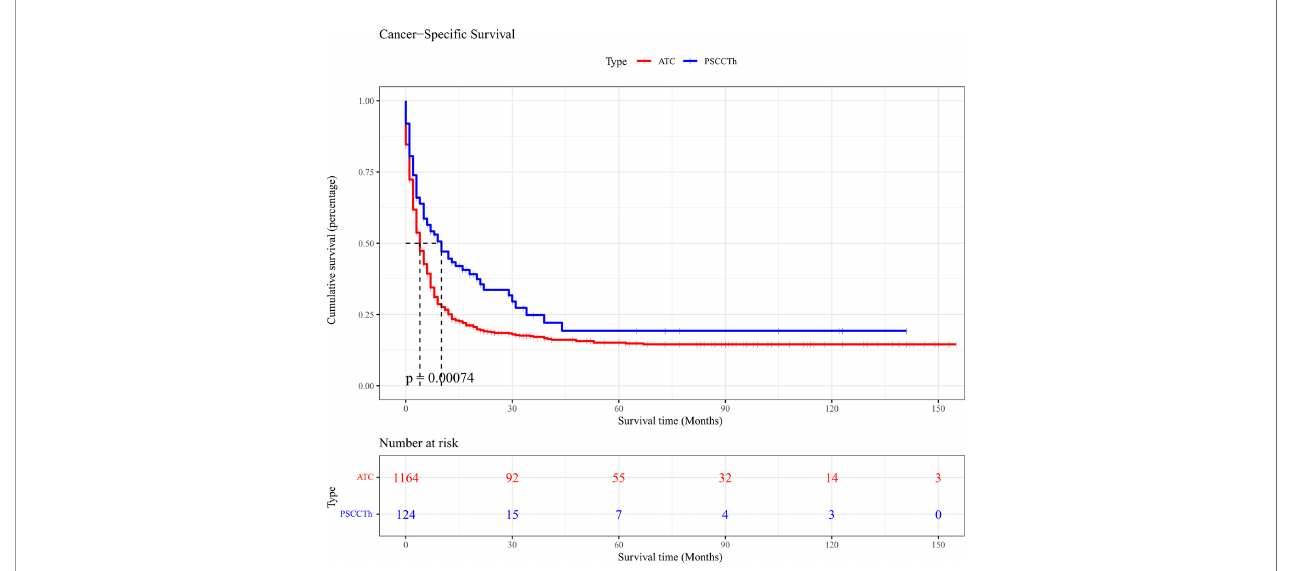
FIGURE 1 | Kaplan-Meier curves of cancer-speci fi c survival in patients with ATC and PSCCTh.